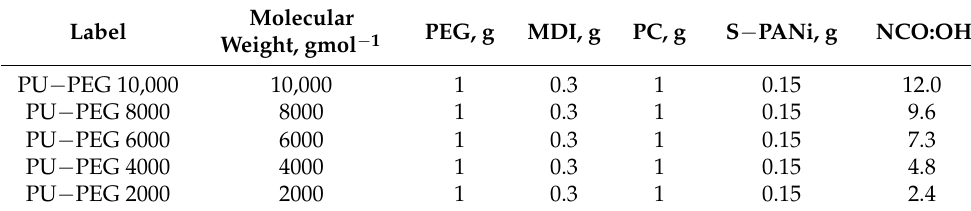
Table 1. Formulation of PU matrices of different PEG molecular weight.